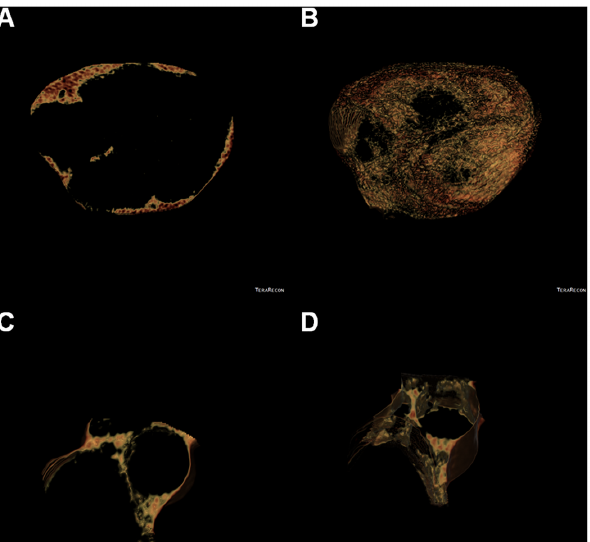
Fig 1. The illustration of single PCF (A) or TAT (C) slice re-construction by using dedicated CT software (Aquarius 3D Workstation, TeraRecon, San Mateo, CA, USA) and subsequent semi- automatic 3D volumes (B: PCF, D: TAT) using CT dataset by summation methods in our current